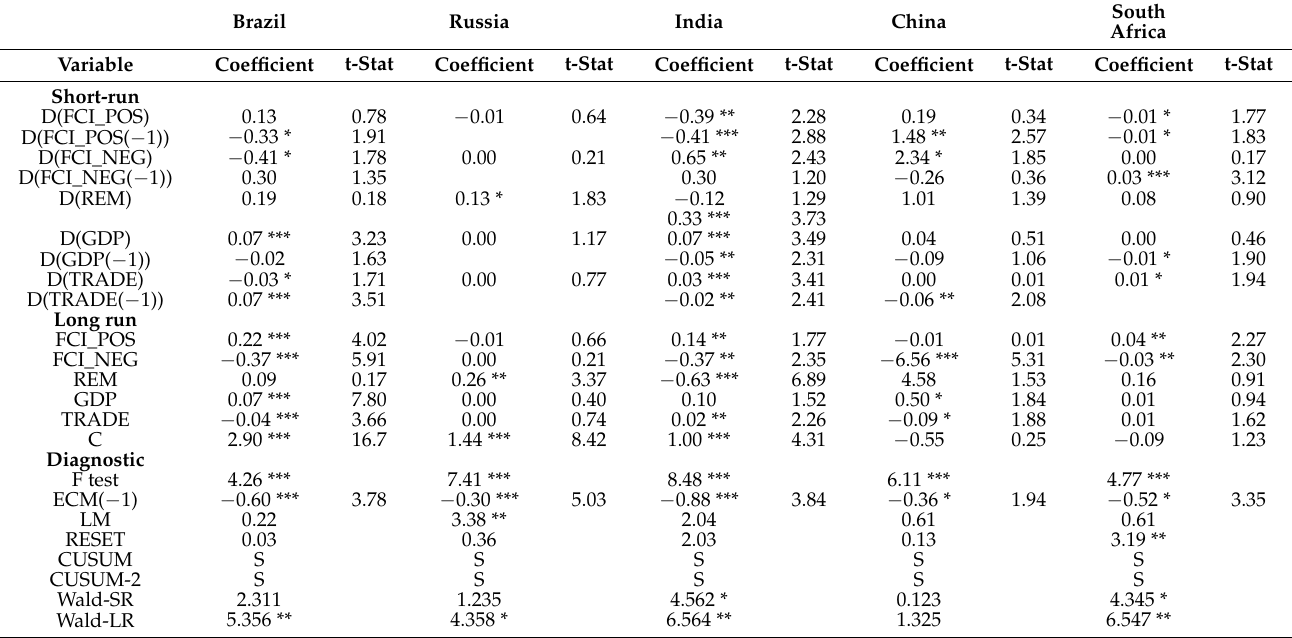
Table 3. Short and long-run NARDL estimates of renewable energy